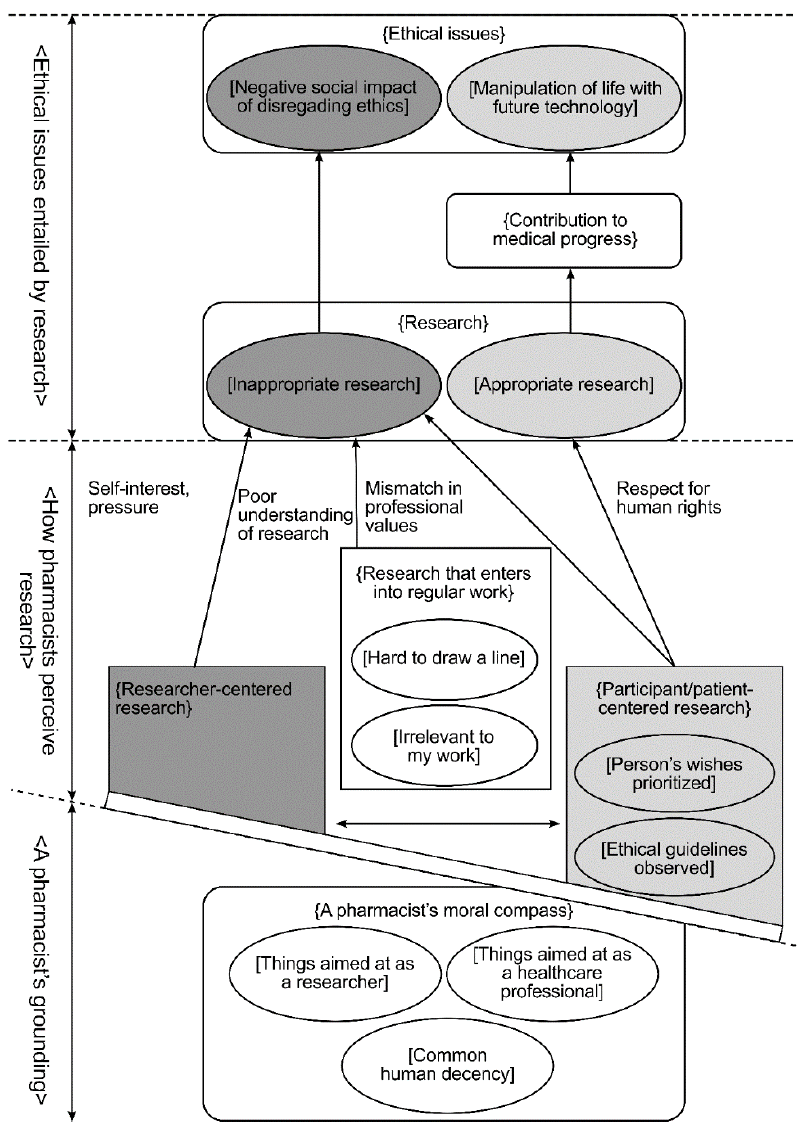
Figure 1. Conceptual diagram of pharmacists’ thoughts on ethics. Note: <> = Categories; {} = Subcategories; [] = Subsubcategories.